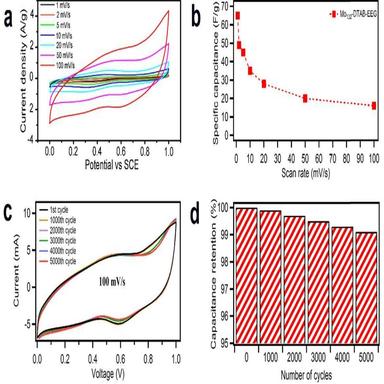
Electrochemical properties of the Mo132-DTAB-EEG hybrid material: (a) CV curves of Mo132-DTAB-EEG at different scan rates, ranging from 1 mV s-1 to 100 mVs-1; (b) Comparison of specific capacitance vs scan rate for Mo132-DTAB-EEG; (c-d) Electrochemical cycling stability of Mo132-DTAB-EEG electrode material, CV curves and capacitance retention measured at a scan rate of 100 mV s-1.